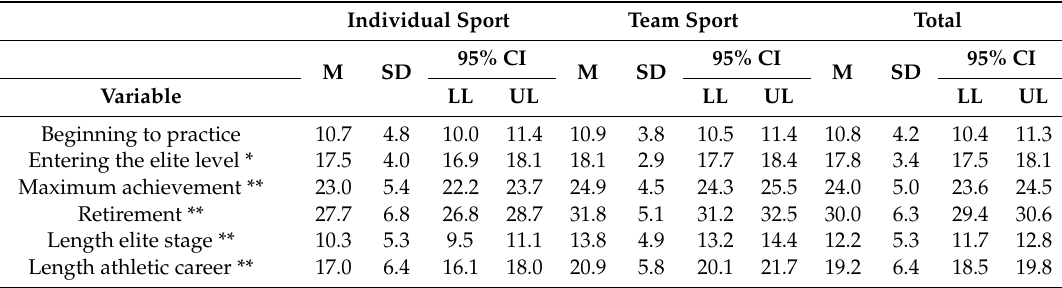
Table 1. Events and length of athletic career regarding the type of sport in